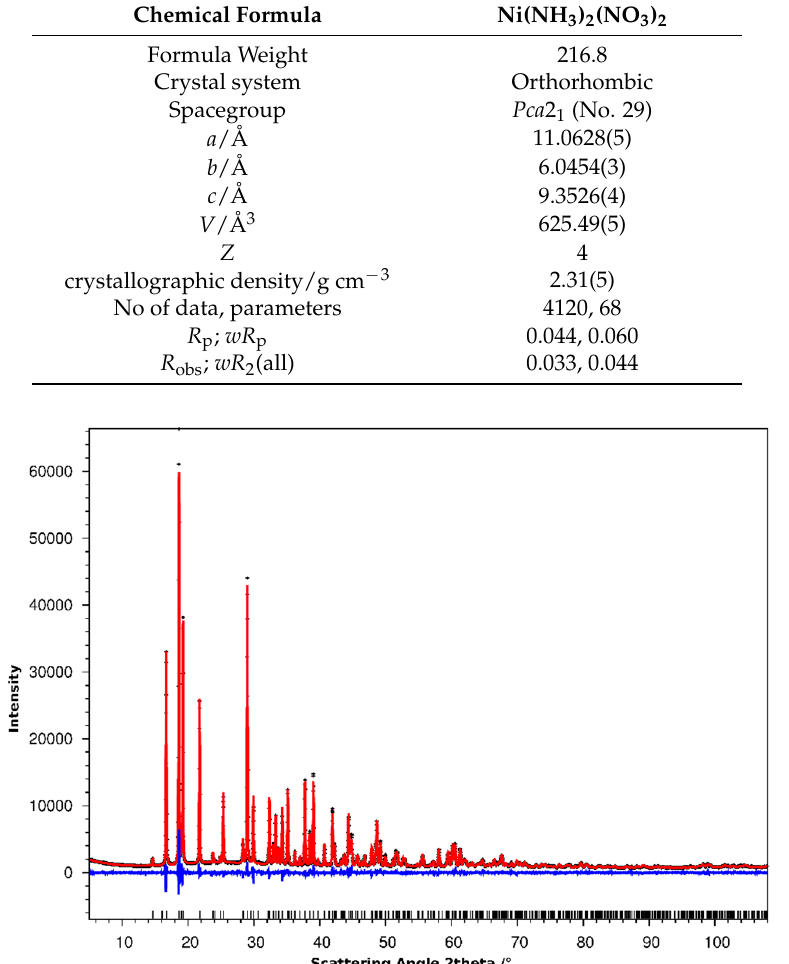
Figure 2. Plot of the measured powder pattern (black crosses) and calculated pattern (red line). The difference plot, ( I obs — I calc ), is denoted by the blue line and the theoretical peak positions are shown as black ticks.